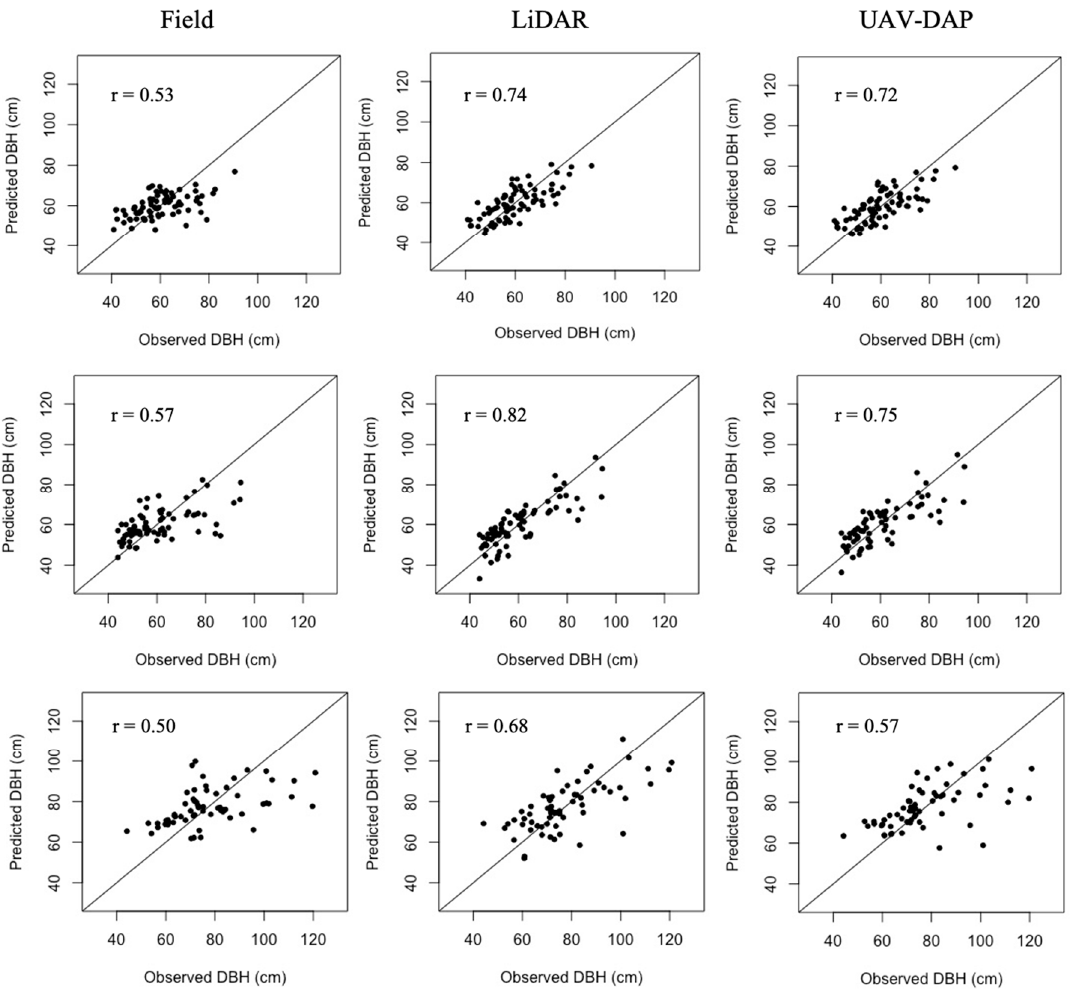
Figure 7. Observed and predicted DBH Values for monarch birch (first row), castor aralia (middle row), and Japanese oak (third row).